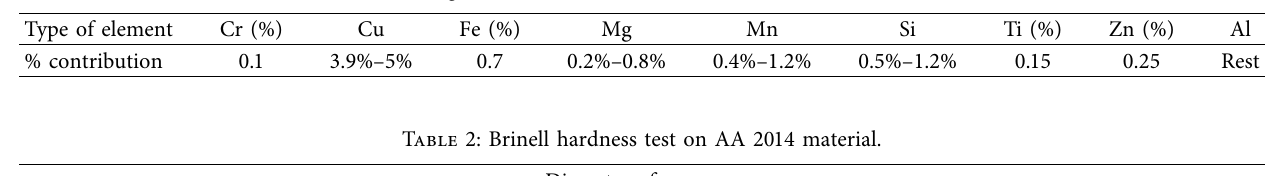
Figure 1: Microstructure of the chosen AA 2014 (black dots represent copper). Table 1: Percentage of elements distribution in the chosen AA 2014 material.